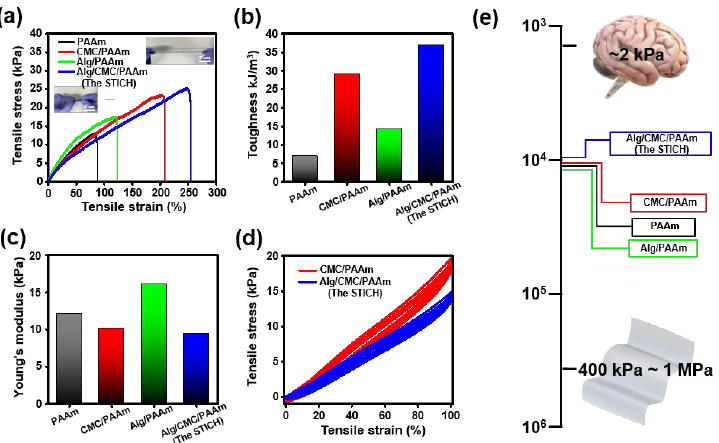
Figure 3. Tensile strength measurements of the Alg, CMC, and PAAm-based conductive hydrogels. ( a ) The graph shows the tensile stress-strain curves (inset image scale bar = 2 cm) of the Alg, CMC, and PAAm-based conductive hydrogels ( n = 3). ( b ) Toughness of the Alg, CMC, and PAAm-based conductive hydrogels ( c ) Young’s moduli of the Alg, CMC, and PAAm-based conductive hydrogels. ( d ) Cyclic stretching data (10 times) of “ CMC/PAAm ” and STICH. ( e ) Young’s moduli on the log scale of the Alg, CMC, and PAAm − based conductive hydrogels, brain, and PDMS. ( “ PAAm ” , black; “ Alg/PAAm ” , green; “ CMC/PAAm ” , red; and “ Alg/CMC/PAAm ” , the STICH, blue).